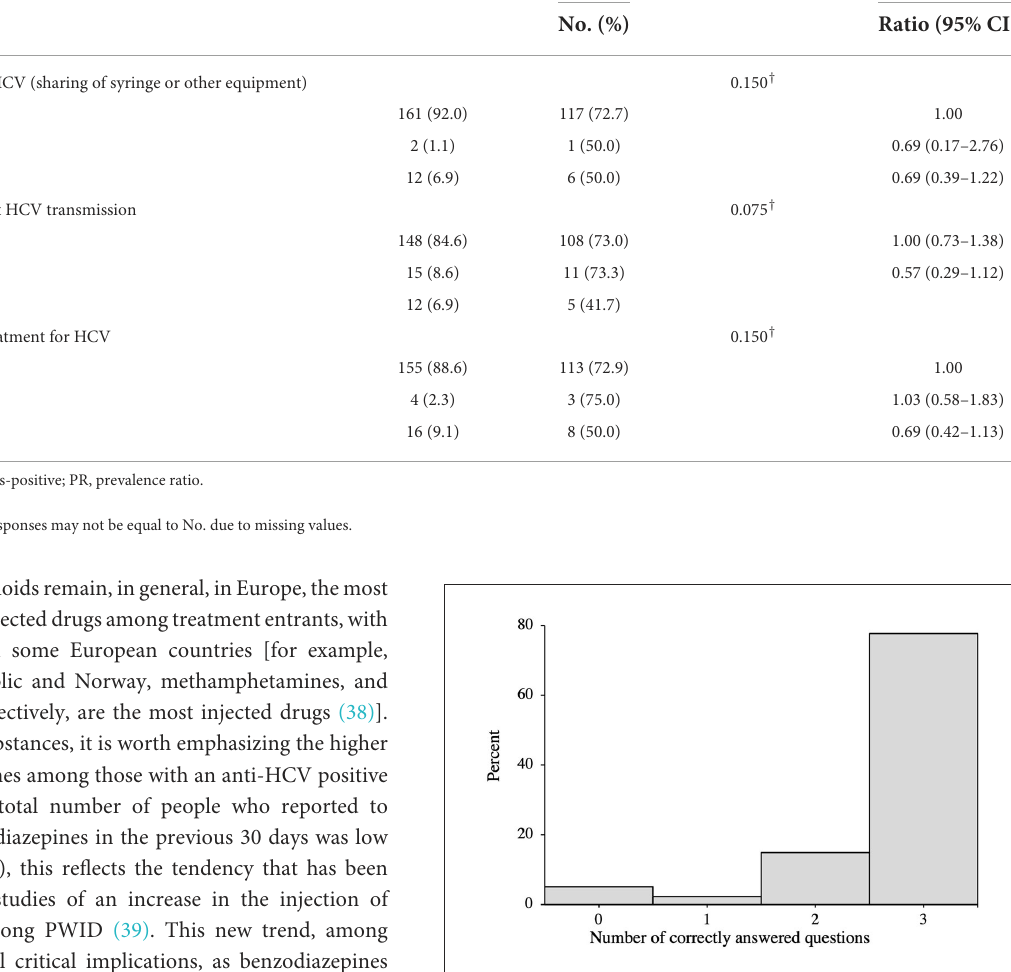
FIGURE1 Knowledge regarding hepatitis C (treatment and